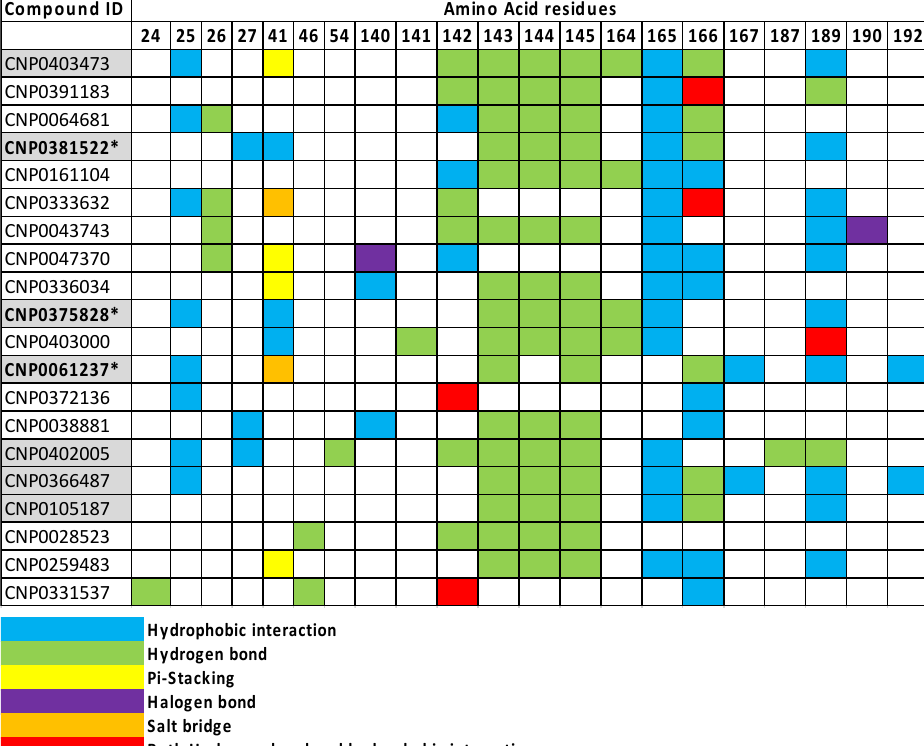
Table 4. Classification of the seven NPs used for in vitro M pro inhibition assay. COCONUT Ids in bold, gray color and with asterisk show in vitro inhibition.